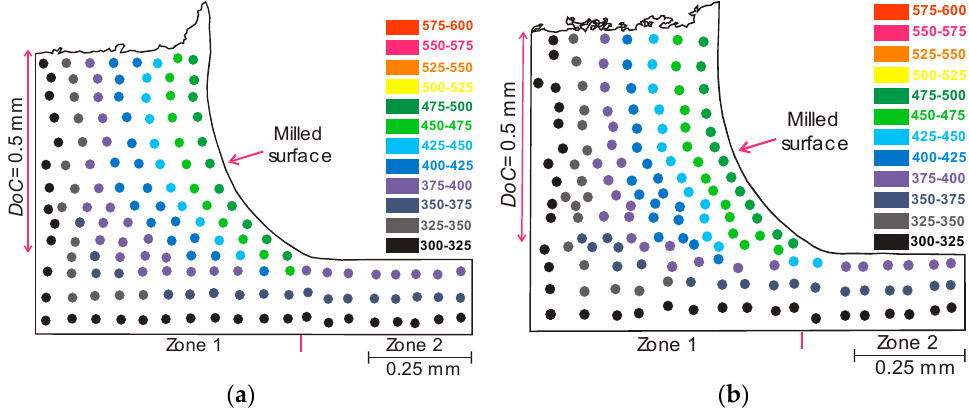
Figure 13. Microhardness (HV) maps on the cross-sections near milled surfaces of tool inserts after the first pass: ( a ) Tool dry4 , and ( b ) Tool wet4 , with f t = 0.1 mm.